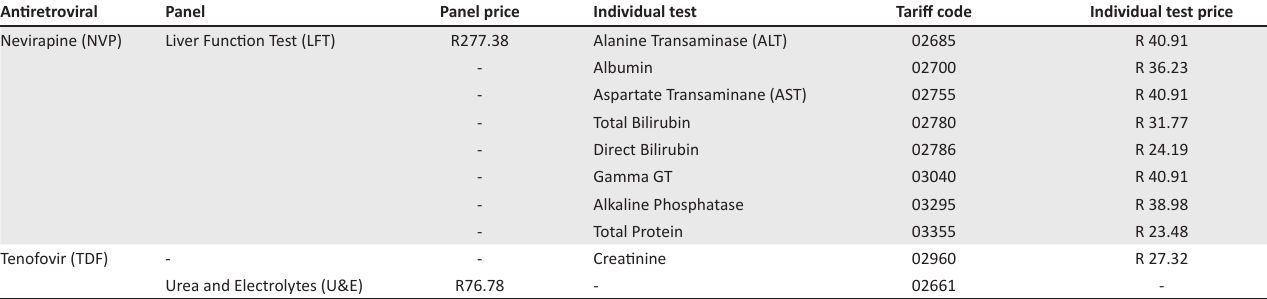
TABLE 1: Classification of conditional grant tariff codes based on the tests requested to differentiate individual and panel testing. Antiretroviral Panel Panel